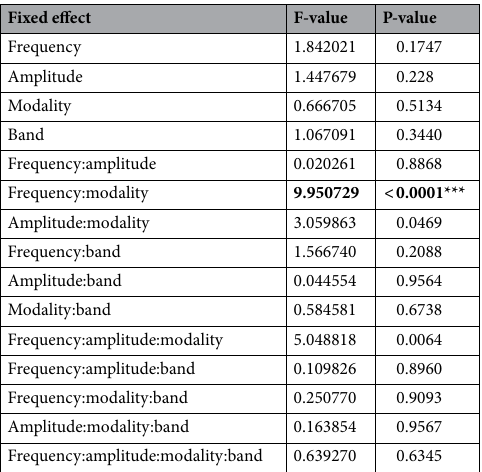
Table 1. Group-level analyses. Multilevel mixed model ANOVA. Bonferroni adjusted significance level =